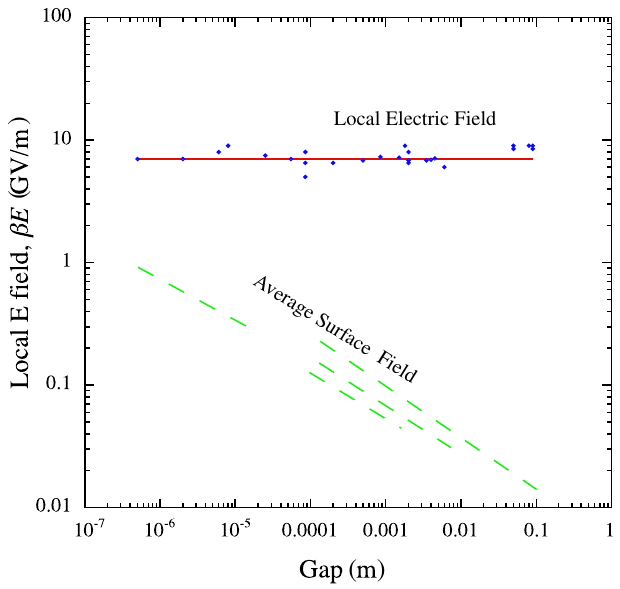
FIG. 16. (Color) Local electric fields, (cid:1)E face fields for DC systems. This data was collected in Ref. [14]. The breakdown model predicts (cid:1)E different geometries